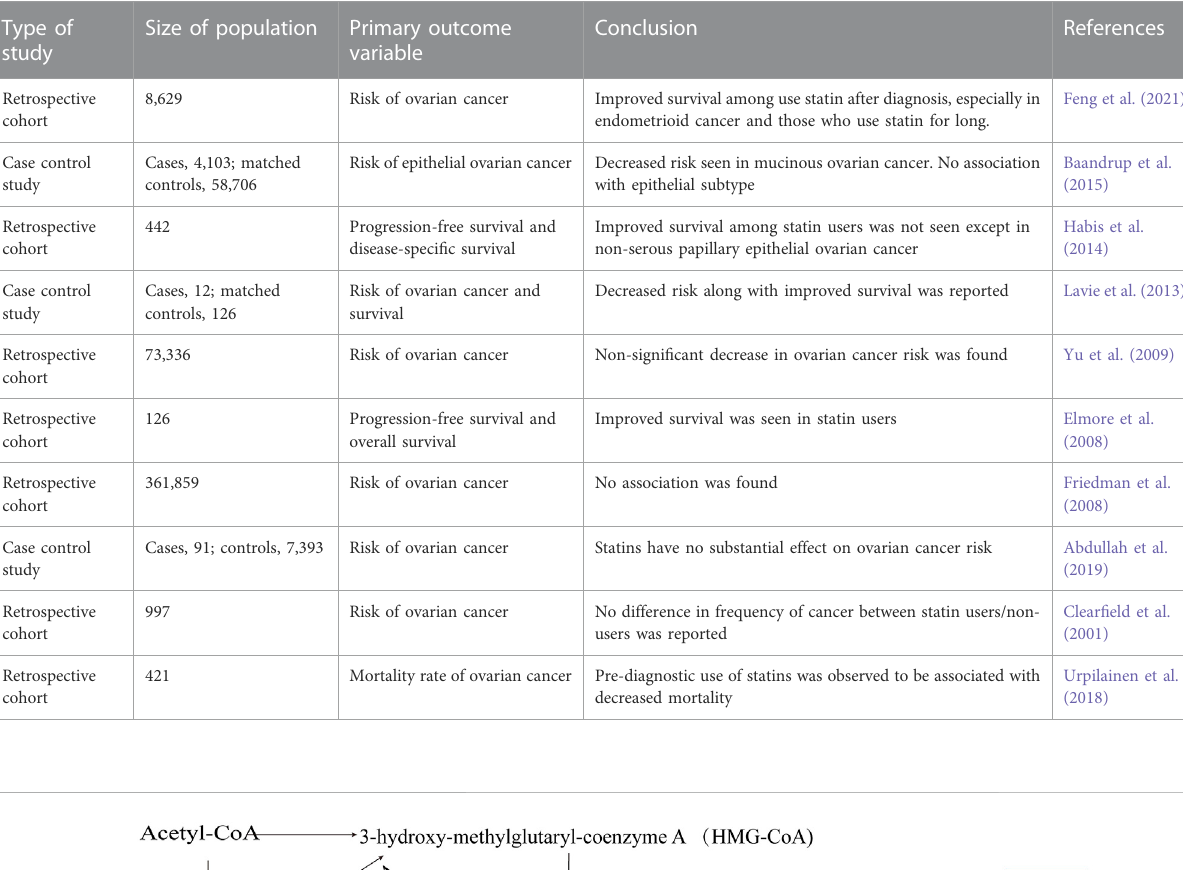
TABLE 2 Summary of the evidence regarding impact of statin therapy on risk and survival of ovarian cancer.